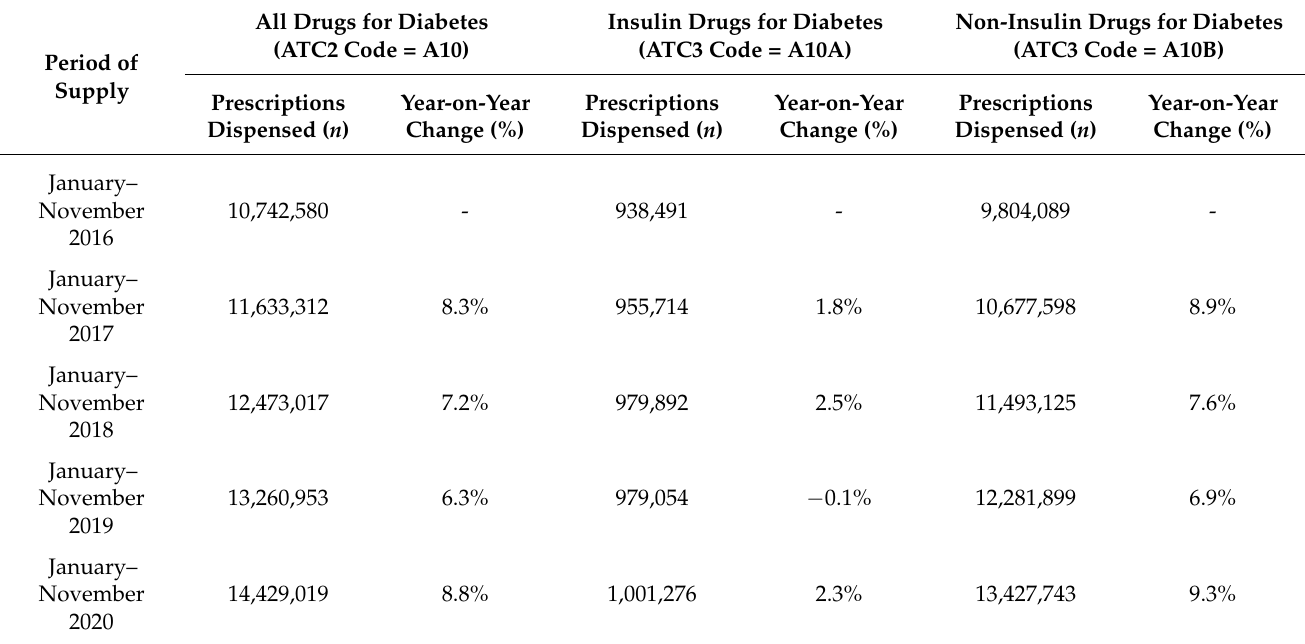
Table 1. PBS dispensed Diabetes medicines January to November by